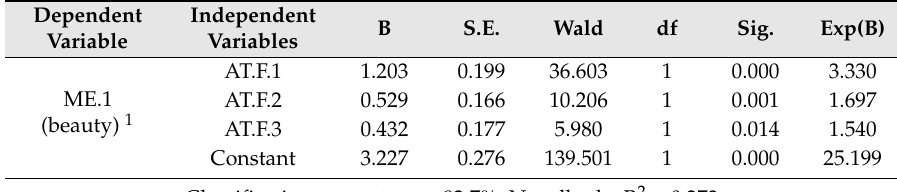
Table 5. The results of the logistic